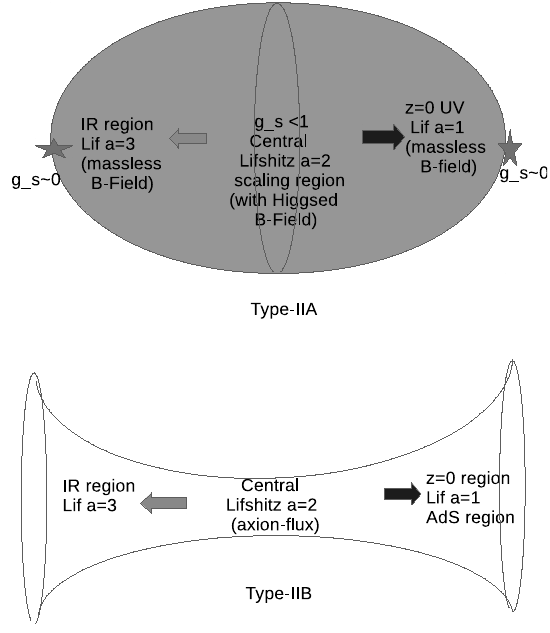
Figure 2 . The figures are drawn for the cascading Lif ( size is indicative of physical radius of y -circle in various z regions. The end stars indicate possible S 1 pinching. In the lower figure the same situation is viewed on type-IIB theory side. The size of T-dual ˜ y -circle is minimum at the throat, supported by constant χ flux. The dynamical effect of flux get diluted in the far IR and UV region. The geometry appears like a traversable